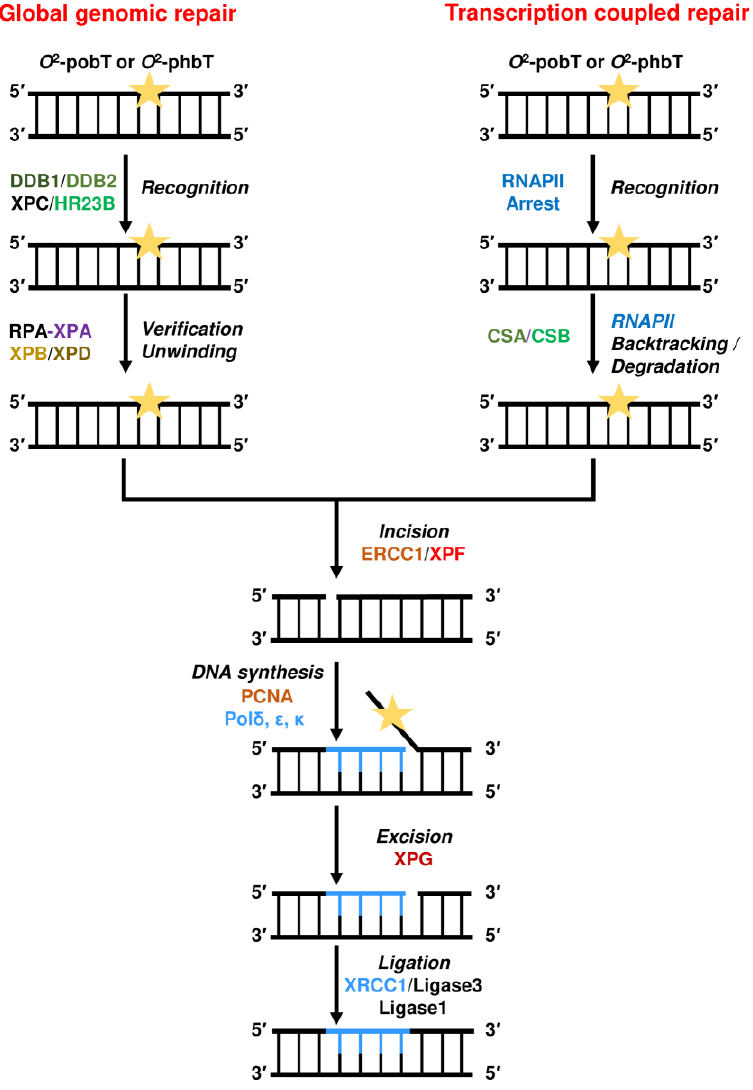
Figure 10. Nucleotide excision repair (NER) of bulky DNA alkylation adducts. Depicted are both global genomic repair and transcription-coupled repair.